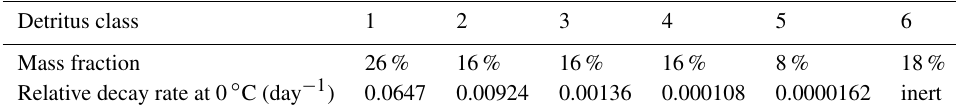
Table B1. Decay rates of different classes of